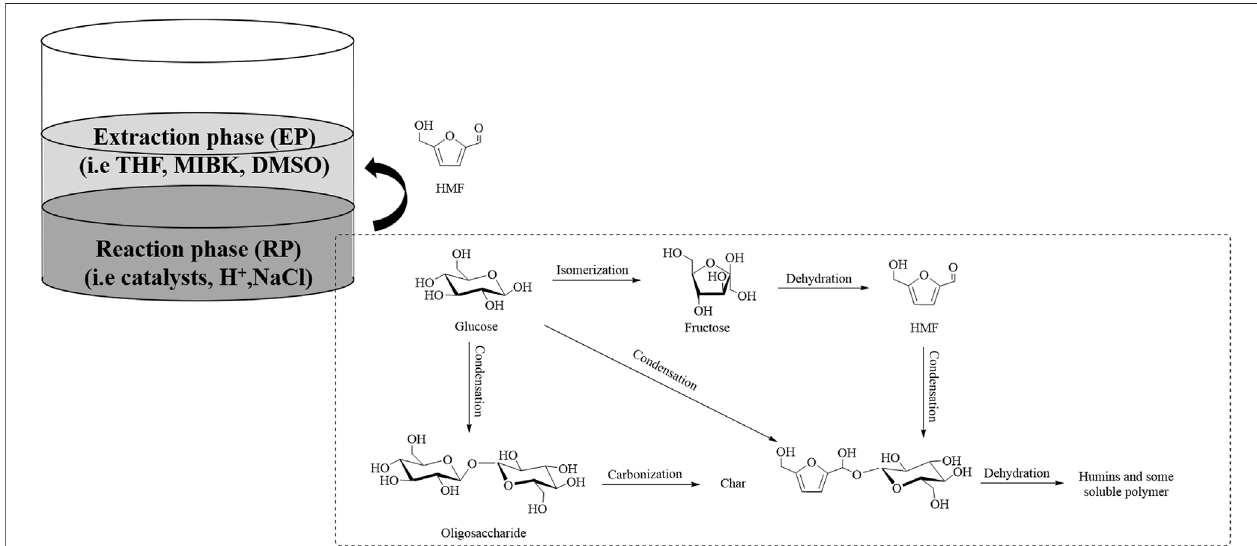
FIGURE 3 | Undesired dehydration and condensation reactions from hydroxymethylfurfural (HMF).